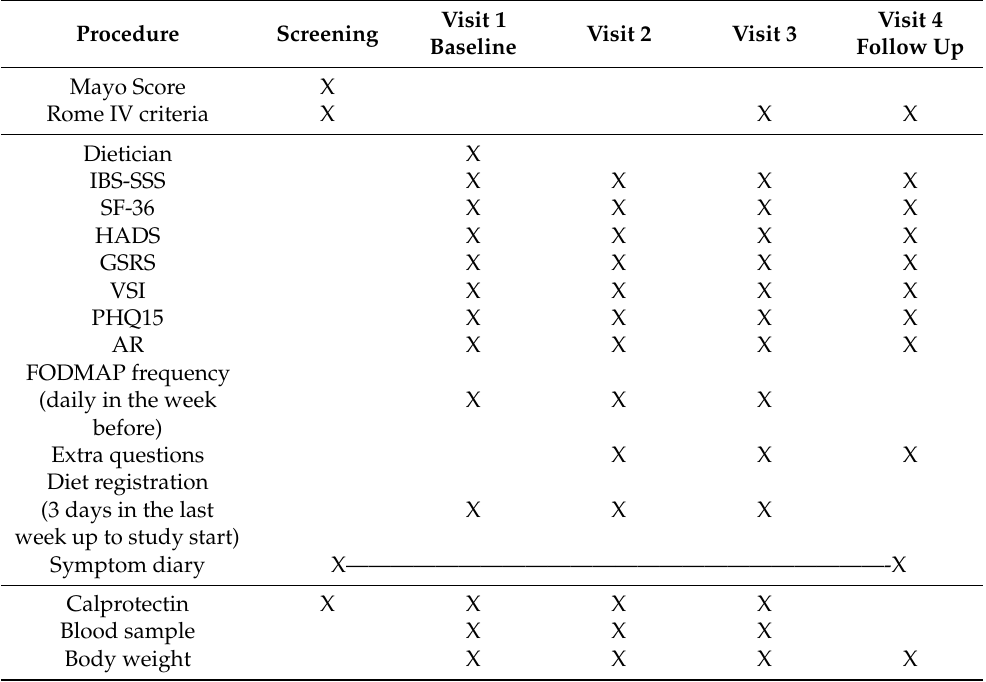
Table 1. Irritable Bowel Syndrome Severity Scoring System (IBS-SSS), Short Form 36 Health Survey (SF-36), Hospital Anxiety and Depression Scale (HADS), The Visceral Sensitivity Index (VSI), IBS specific Gastrointestinal Symptom Rating Scale (GSRS-IBS), Patient Health Questionnaire (PHQ 15), Irritable Bowel Syndrome Adequate Relief